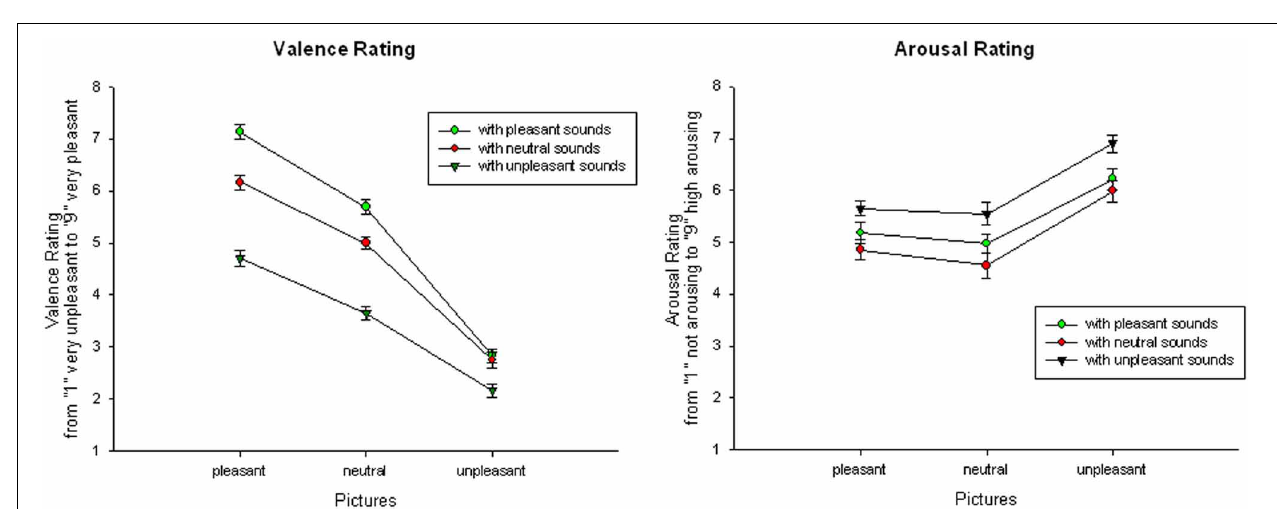
FIGURE 1 | Valence (left) and arousal (right) ratings for audiovisual presentations: Mean and SEMs of valence and arousal ratings for pleasant, neutral, and unpleasant pictures in combination with pleasant, neutral, and unpleasant sounds.